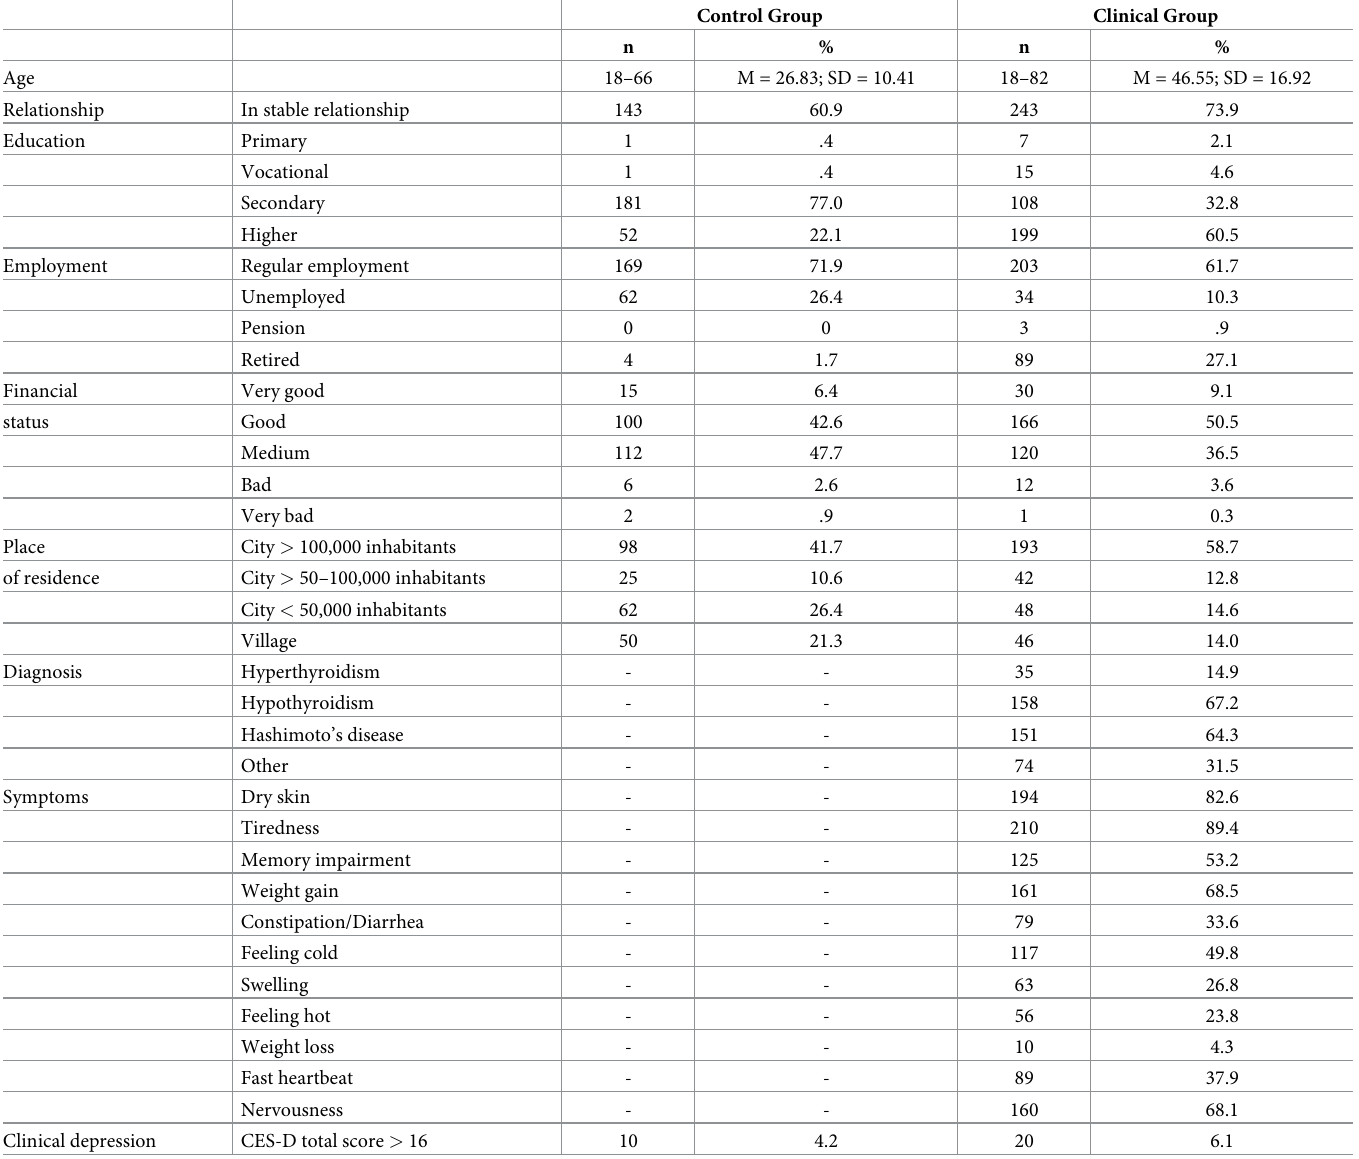
Table 1. Demographic characteristics of entire sample (n =